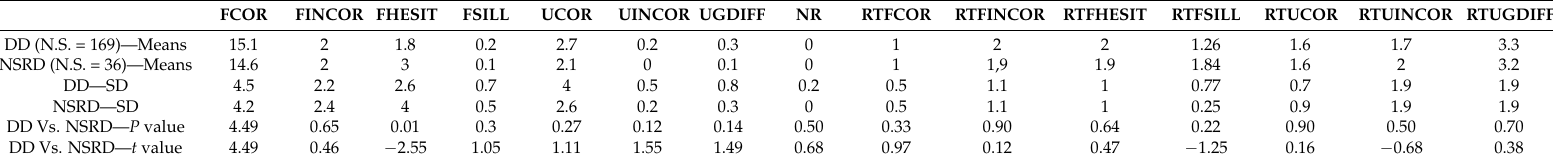
Table 4. t -test results of the reading test of DTRS of the two groups: mean, SD, t -value and p -value. SD = standard deviation, FCOR = number of words correctly read in flash mode, FINCORCOR = number of words incorrectly read in flash mode, FHESIT = number of words hesitating read in flash mode, FSILL = number of words syllabicating read in flash mode, UCOR = number of words correctly read in untimed mode, UINCOR = number of words incorrectly read in untimed mode, UGDIFF = number of words read with great difficulty in untimed mode, NR = number of words not read, RTFCOR = averaged reading time of words correctly read in flash mode, RTFINCORCOR = average reading time of words incorrectly read in flash mode, RTFHESIT = average reading time of words hesitating read in flash mode, RTFSILL = average reading time of words syllabicating read in flash mode, RTUCOR = average reading time of words correctly read in untimed mode, RTUINCORCOR = average reading time of words incorrectly read in untimed mode, RTUGDIFF = average reading time of words read whit great difficulty in untimed